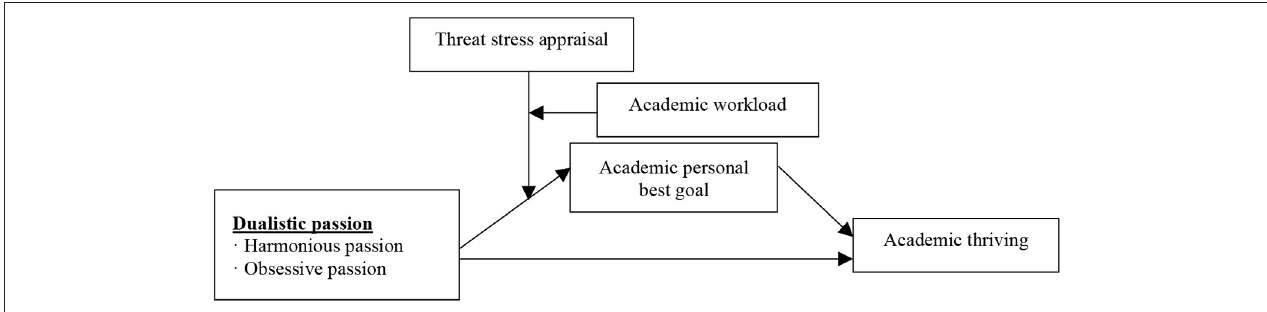
FIGURE 1 | Theoretical